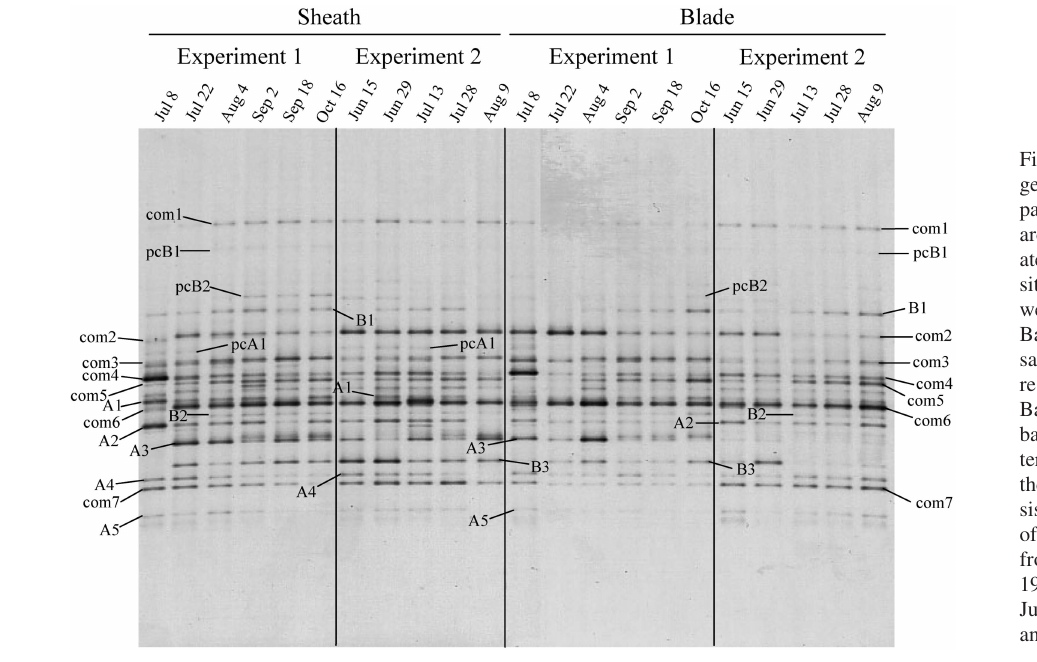
Figure 1. Denaturing gradient gel electrophoresis (DGGE) patterns of methanogenic archaeal communities associ- ated with rice straw decompo- sition. Bands labeled “com” were present in all